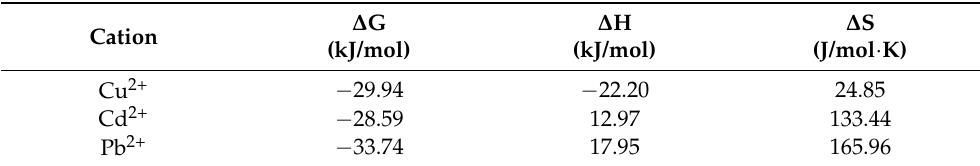
Table 5. Thermodynamic parameters calculated for the adsorption processes of Cu 2+ , Cd 2+ and Pb 2+ cations onto the oxidized wool